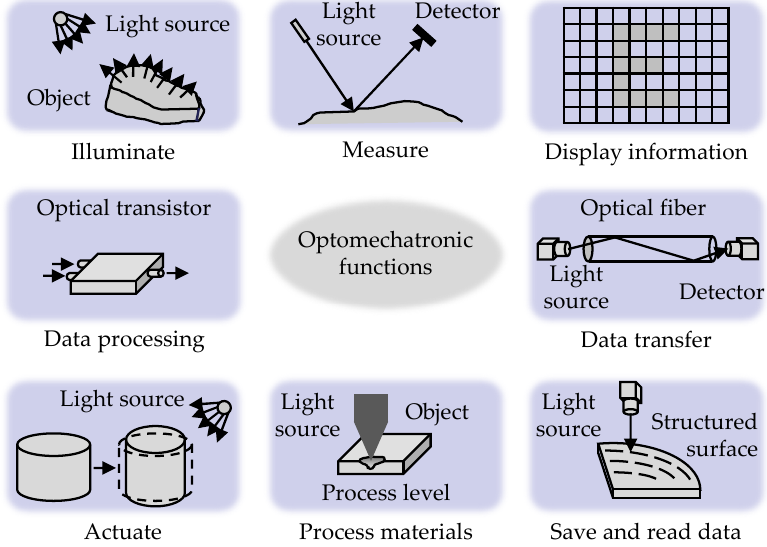
Figure 1. Basic functions of optomechatronic systems according to